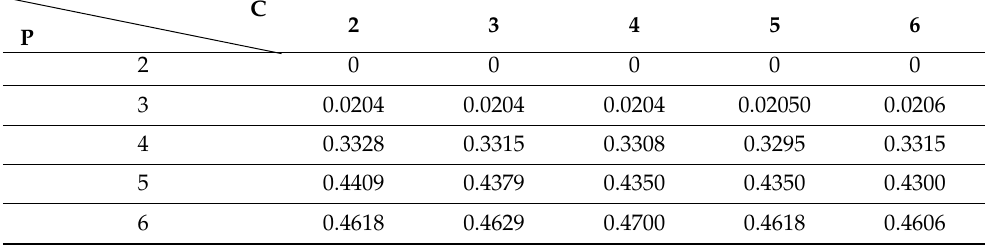
Table 1. Prediction performance CGK-based fuzzy granular model that generated contexts uniformly.